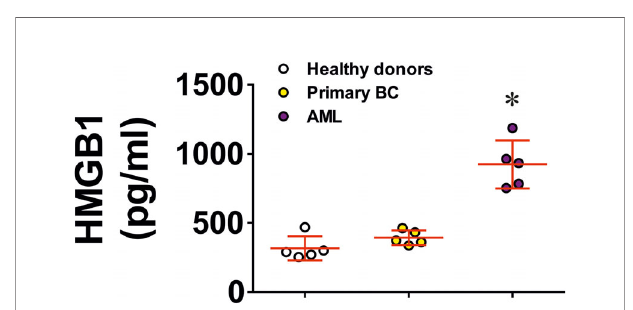
FIGURE 6 | HMGB1 levels in blood plasma of human healthy donors and cancer patients. HMGB1 levels were detected in blood plasma of 5 healthy donors, 5 primary breast cancer (BC) patients, 5 metastatic breast cancer patients and 5 AML patients. Data are mean values ± SEM of 5 independent experiments. Individual values for each patient are shown as well. *p < 0.05 vs healthy